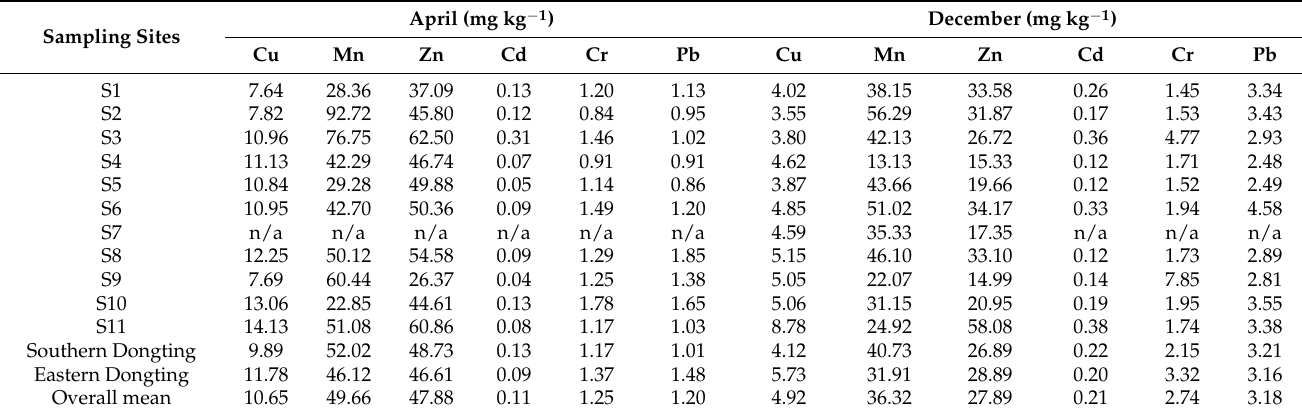
Table 2. Heavy metal concentration of the April-harvested stems and December-harvested above- ground biomass (stems and leaves together) across the 11 sampling